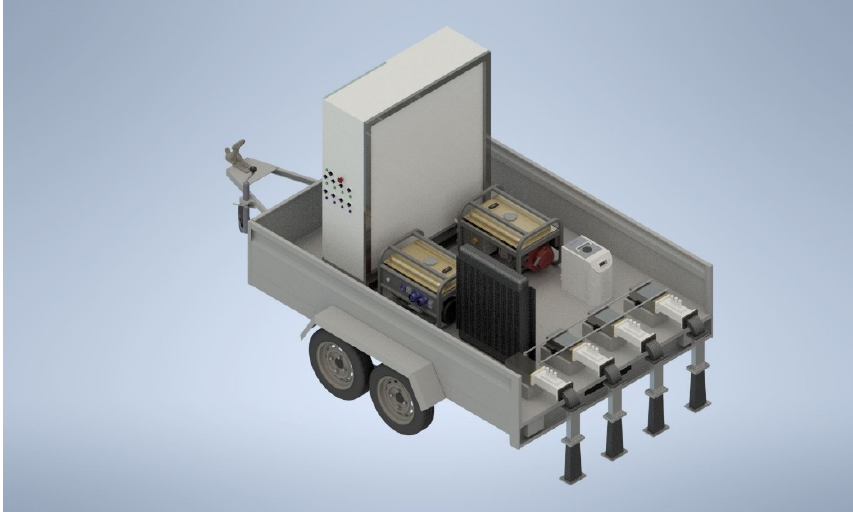
Figure 2. Rendering of experimental microwave trailer with four 2-kW microwave generators on board.